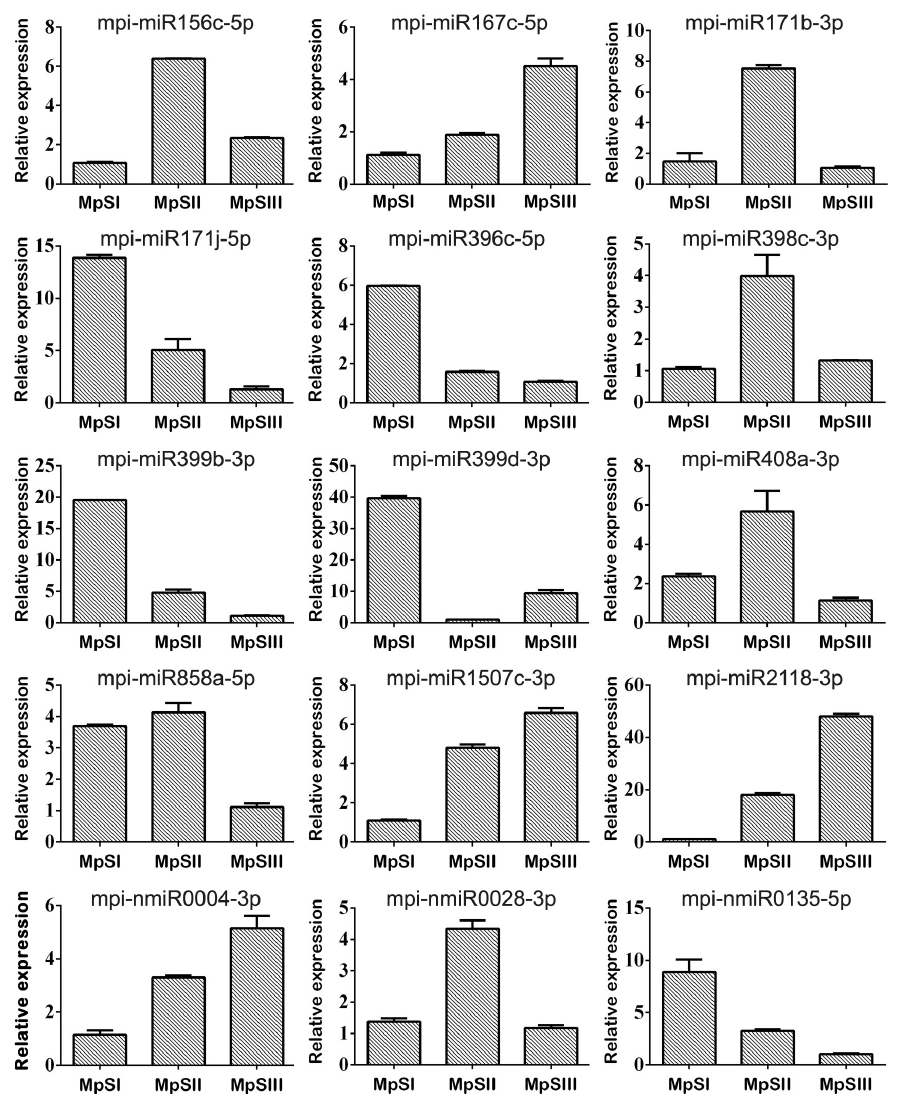
Figure 3. Relative expression levels of 15 DEmiRs evaluated by stem-loop qRT-PCR. An U6 snRNA gene of Pongamia was used as internal control. Bars represent standard deviations of three technical replicates.